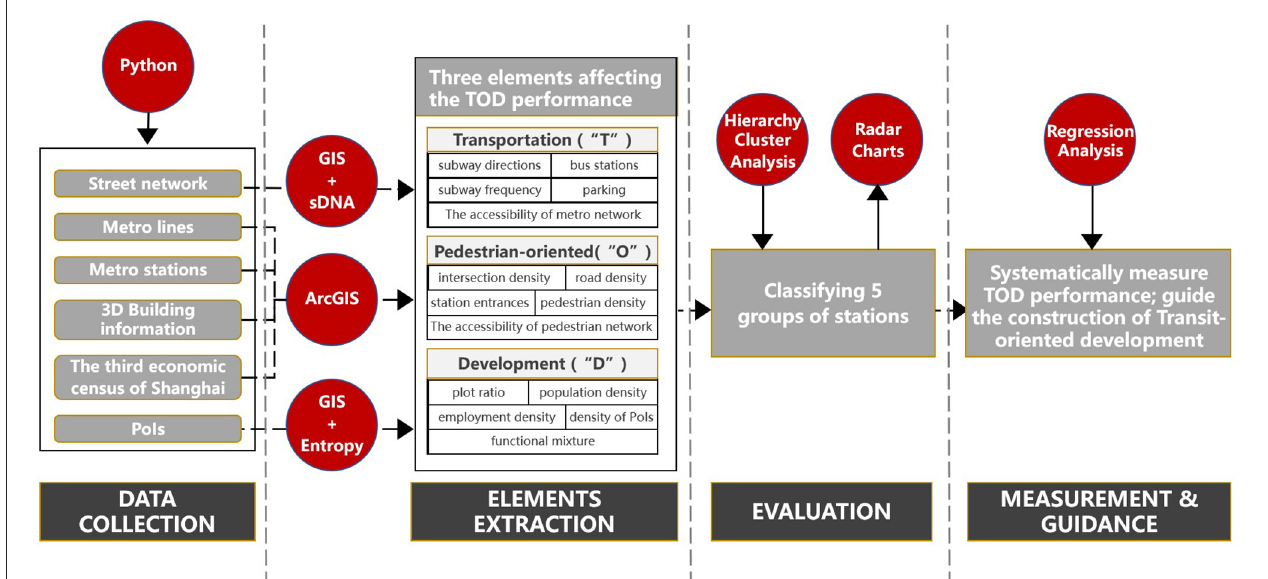
FIGURE 1 | Analytic framework.